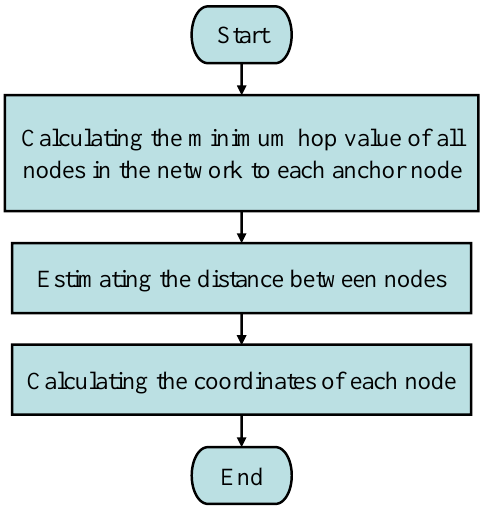
Figure 2. Flow chart of DV-Hop algorithm.